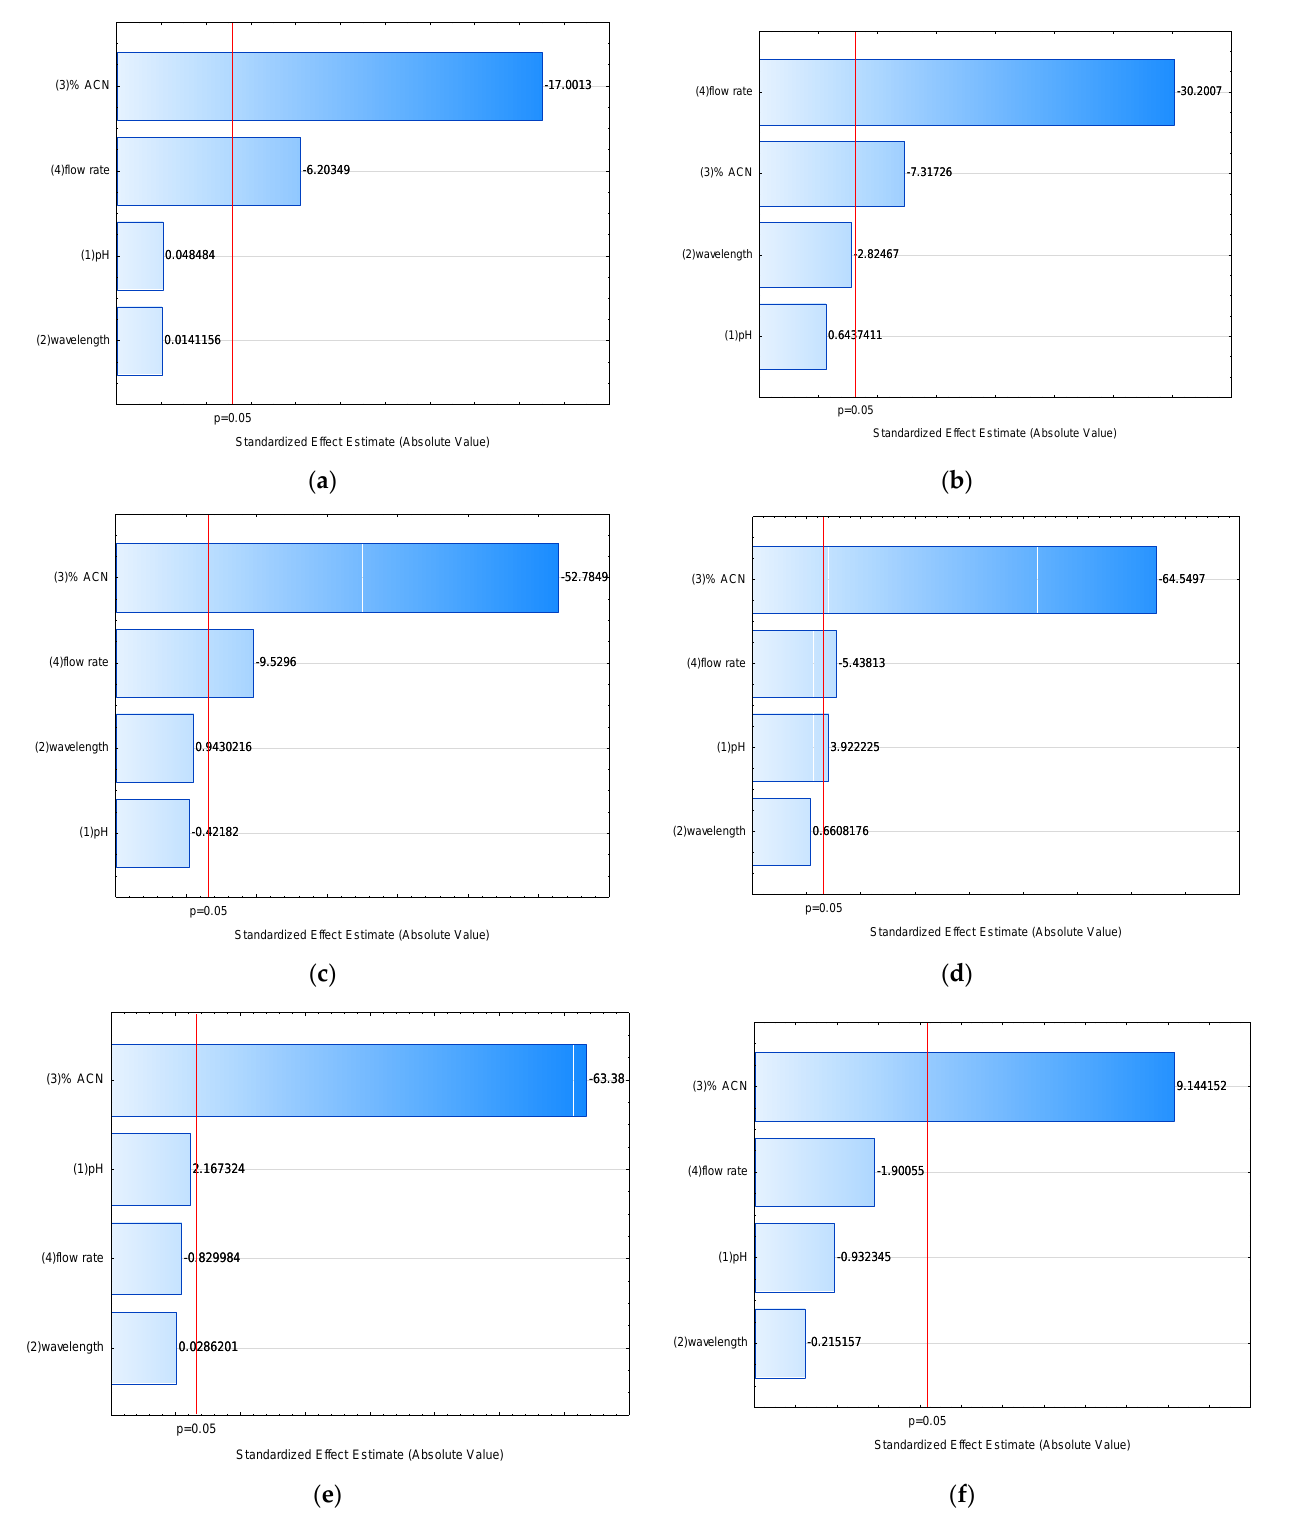
Figure 3. Pareto charts of standardized effects of examined operating factors (%ACN, flow rate, pH, wavelength) on responses: ( a ) retention time; ( b ) peak area; ( c ) theoretical plate number; ( d ) resolution; ( e ) capacity factor; ( f ) tailing factor.